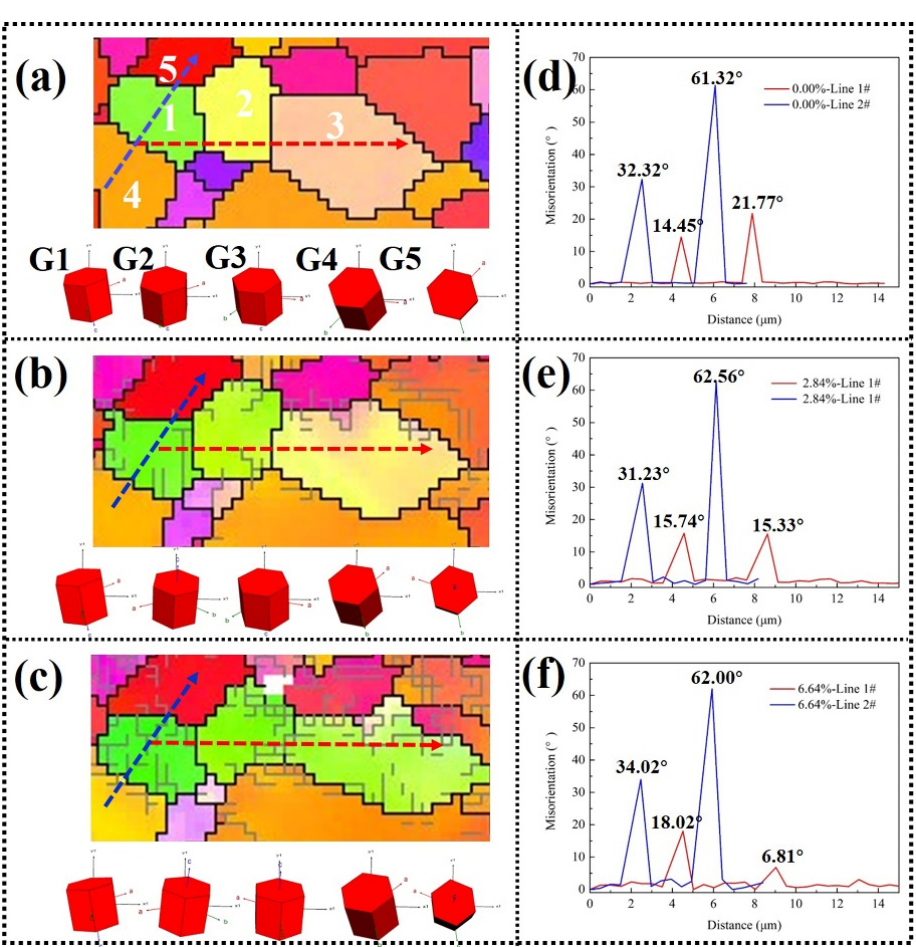
Figure 9. Enlarged region ( a – c ) of the yellow ellipse lines in Figure 4a at different strains and the corresponding misorientation angles distribution ( d – f ) along red and blue lines.